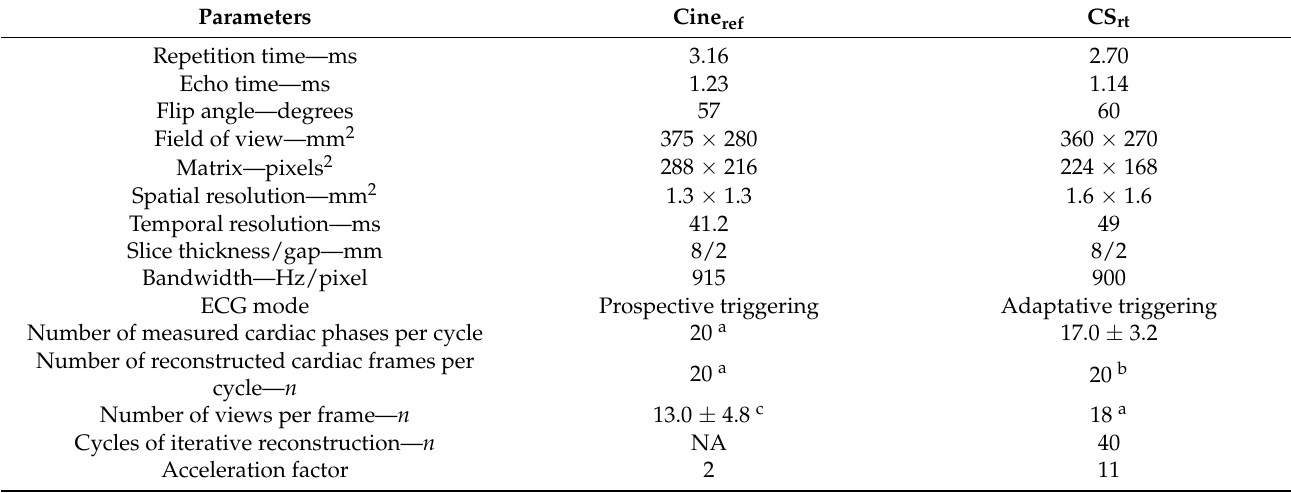
Table 1. Imaging parameters of the reference prospectively triggered steady-state free-precession cine imaging and real-time compressed sensing cine